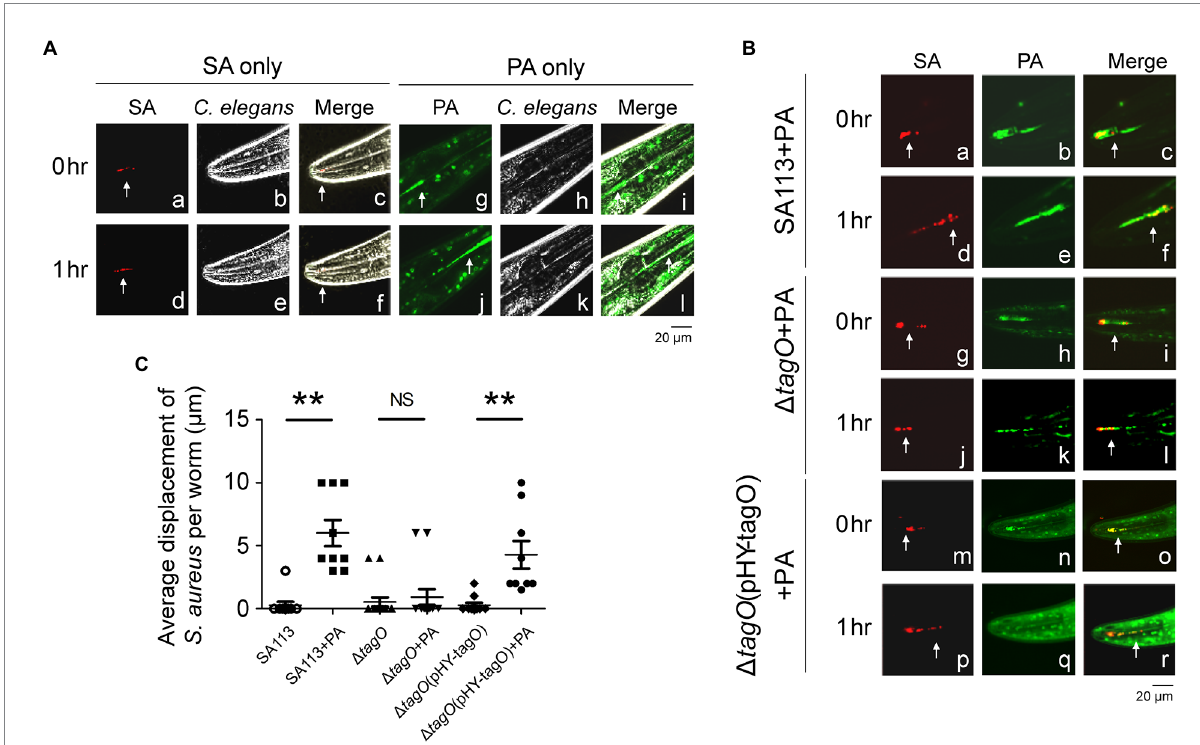
FIGURE 4 Pseudomonas aeruginosa promoted the movement of Staphylococcus aureus in Caenorhabditis elegans . (A) Caenorhabditis elegans were placed on TSA plates that had been inoculated with S. aureus SA113(pCtuf-ppmch; SA) or CYTO 9-labeled P. aeruginosa PAO1 (PA). (B) CYTO 9-labeled P. aeruginosa PAO1 (PA) was mixed with S. aureus SA113(pCtuf-ppmch) (a–f), Δ tagO (pCtuf-ppmch) (g–l) and Δ tagO (pHY-tagO, pCtuf-ppmch) (m–r) and inoculated on TSA plates. The worms were placed on the bacteria-containing agar, and fluorescence (white arrow) in the digestive tracts of C. elegans was imaged under a confocal laser-scanning microscope. Another image was obtained at the same location of the worm 1 h later. Autofluorescence (green) was observed in the C. elegans background. Phase-contrast microscopy images showed the shape of the worm. Merged images showed that bacteria were located inside C. elegans . The images shown are representative of each group ( n ≥ 7 per group). (C) The distance of bacterial migration was measured using FV10-ASW 4.2 software. Data are presented as the mean of the results from each group and were analyzed statistically using Kruskal–Wallis test. Error bars indicate standard deviations. Significant differences ( p < 0.01) are denoted as **. NS, no